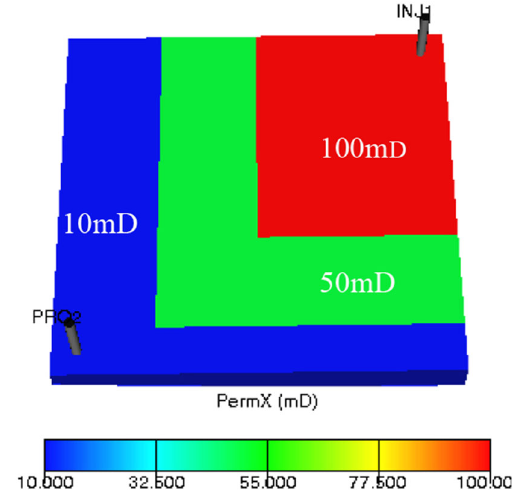
Fig. 1 Permeability model for injecting into thin layers and produc- ing from thick